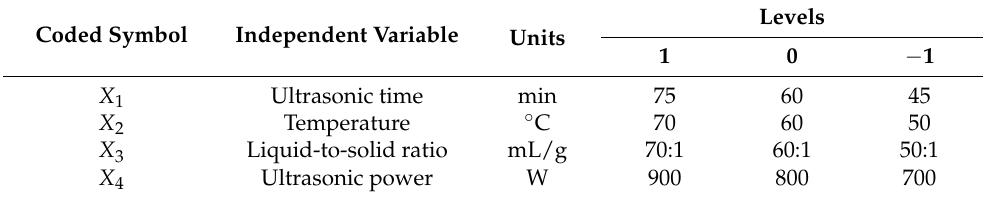
Table 4. Design factor and horizontal coding of response surface